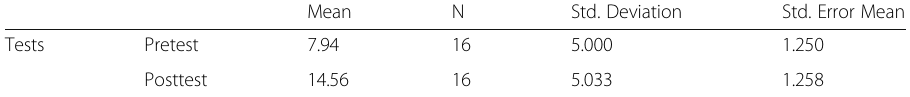
Mean N Std. Deviation Std. Error